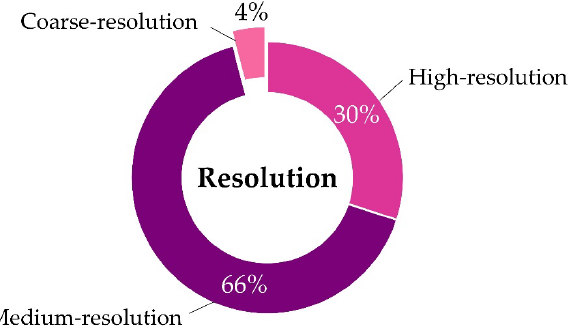
Figure 13. Frequency of high-resolution, medium-resolution, and coarse-resolution images used in wetland studies.